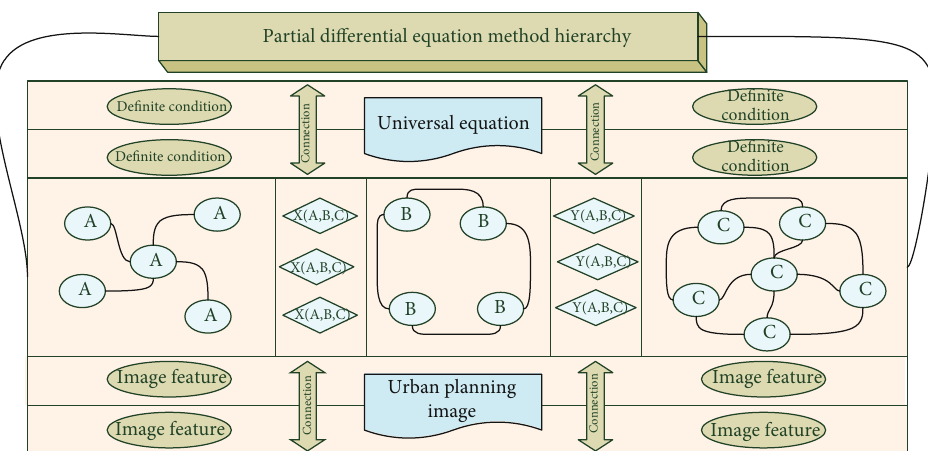
Figure 1: Partial di ff erential equation method hierarchical distribution